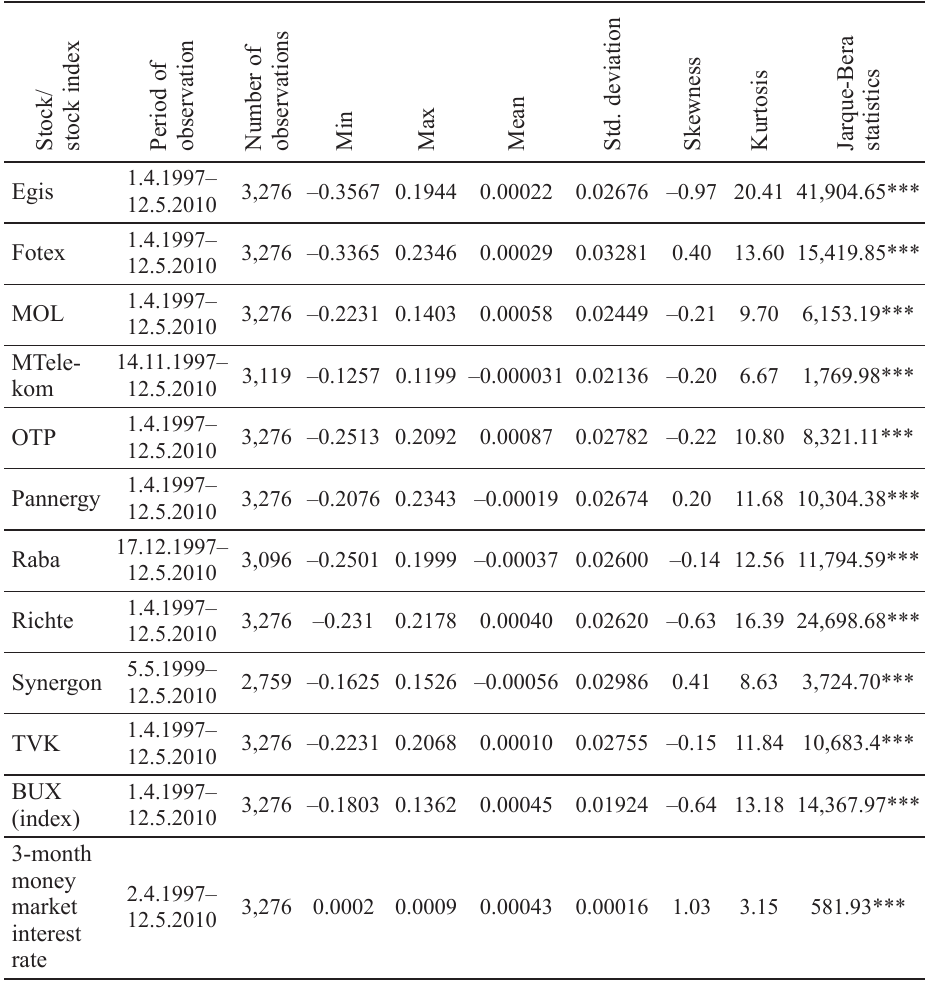
Table 2. Descriptive statistics for returns series of stocks listed at Hungarian stock